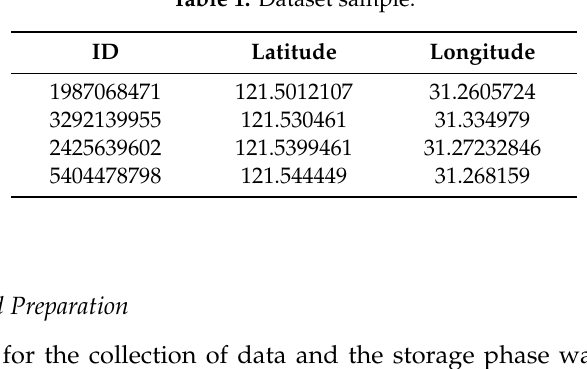
Table 1. Dataset sample.